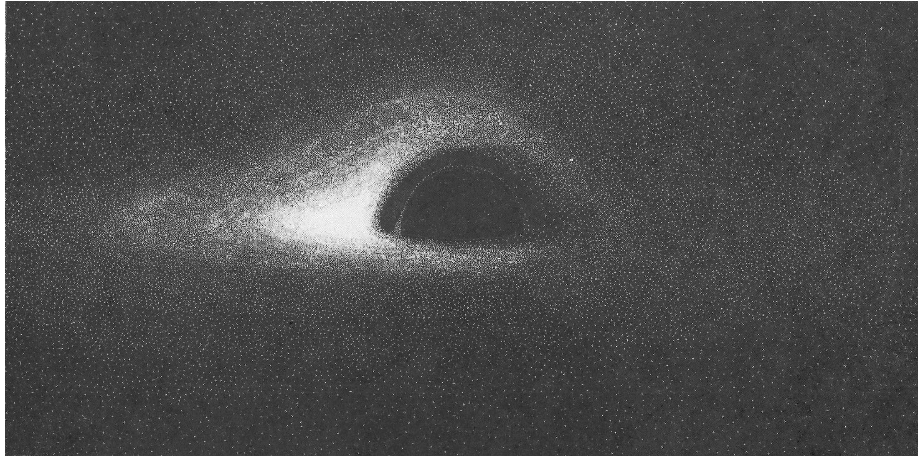
Figure 1. Simulated photograph of a spherical black hole with thin accretion disk. The system is seen from a great distance by an observer at 10° above the disk’s plane, in a frame at rest with the black hole. © J.-P. Luminet, from [3].